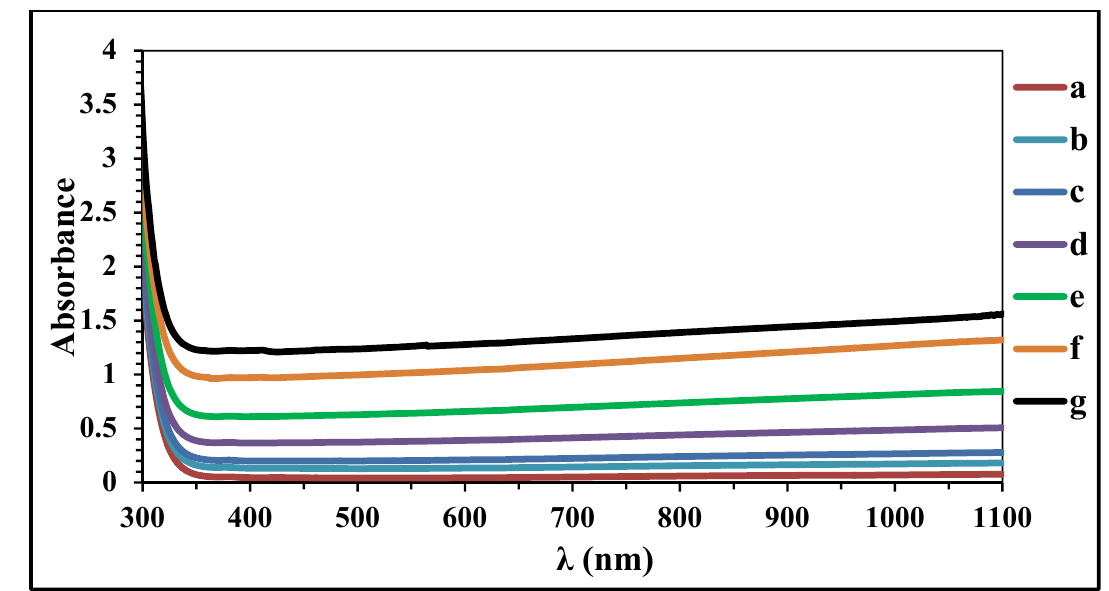
Fig.3: Optical the absorbance for solid films of (PVA\CuI) polymer composites with different concentrations of CuI .a- 0wt% (b)1wt% (c)3wt% (d)5wt% (e)7wt% (f)9wt%